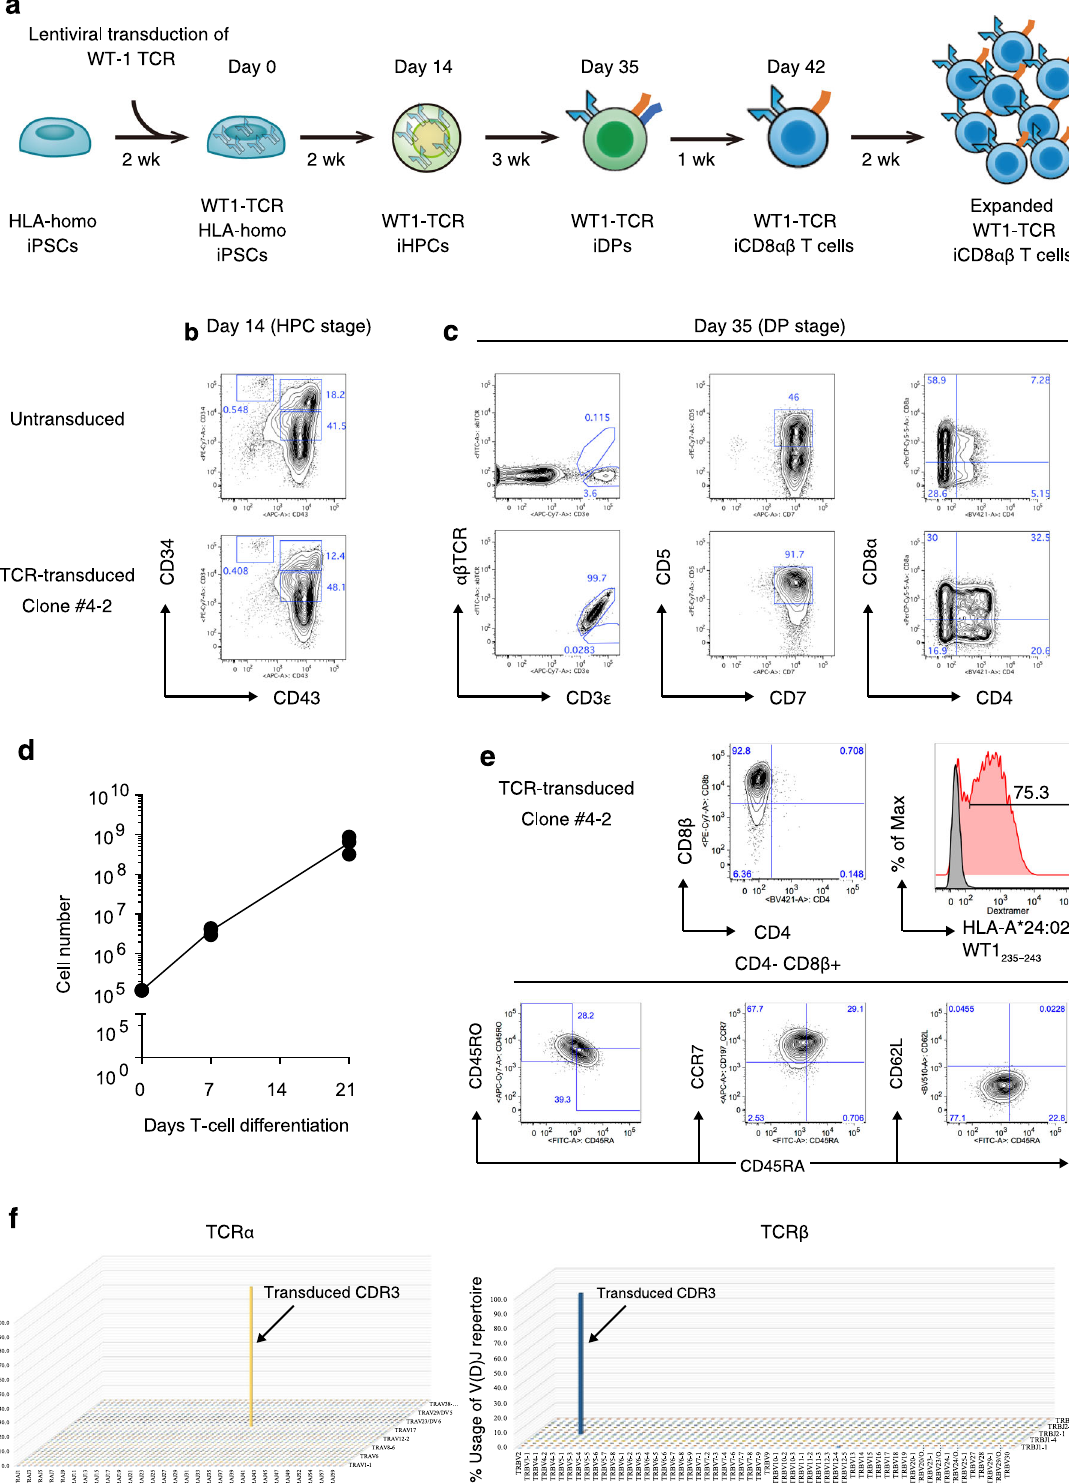
bearing mice (Supplementary Fig. 10a). In PBS control, and iT cell recipients, tumor cells rapidly disseminated throughout the body and all recipients died or were euthanized due to signi fi cant weight loss by 3 weeks after cell injections. On the other hand, recipients of iCART cells showed delayed relapse and superior overall survival compared to the control group and recipients of iT cells (Fig. 6f and g). Flowcytometric analysis of bone marrow